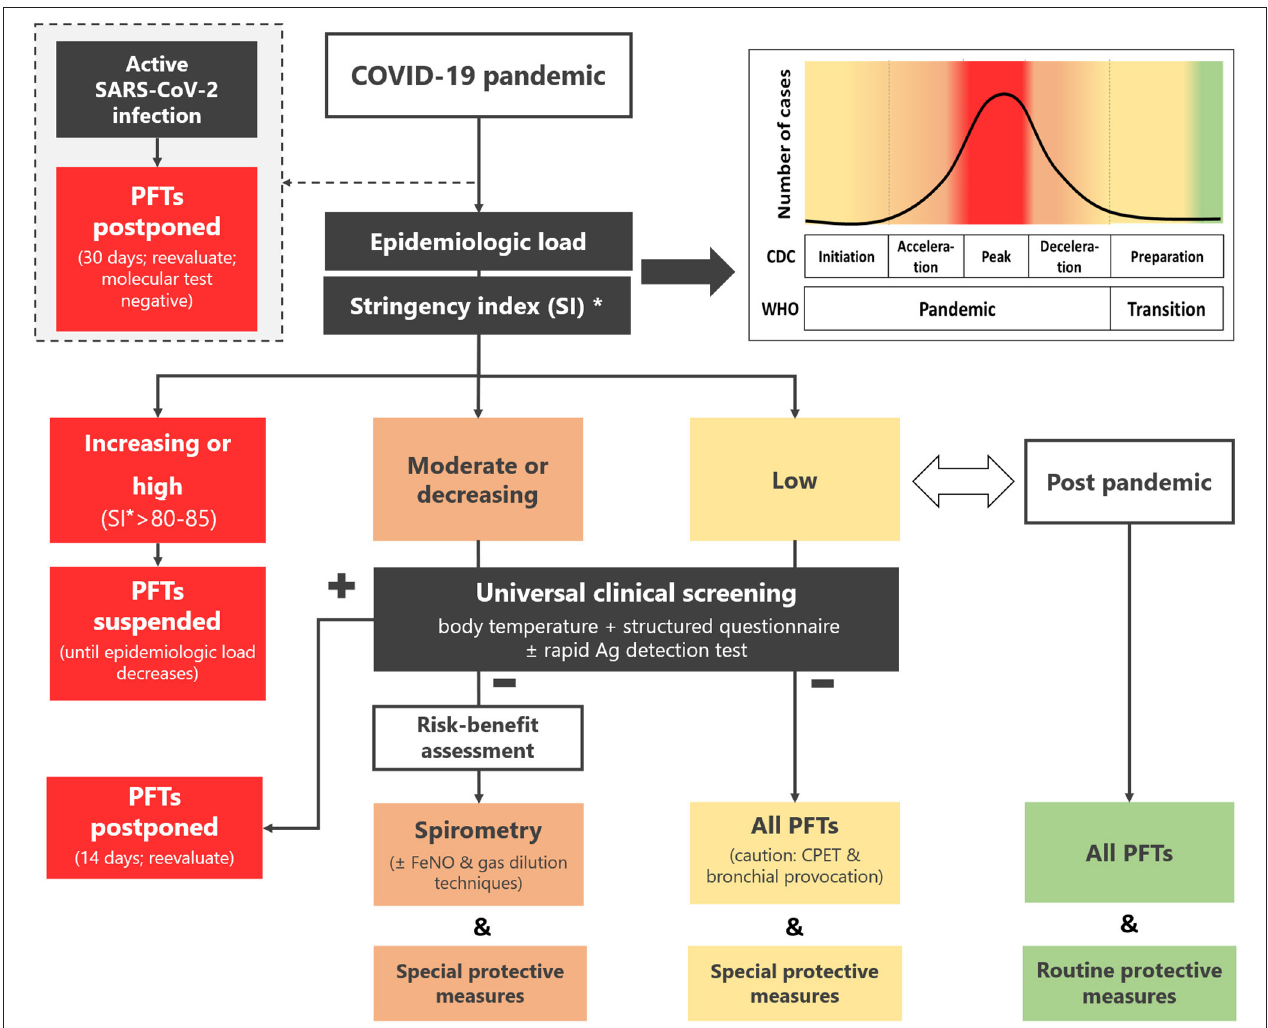
FIGURE 1 | Recommendation of the Hellenic Pediatric Respiratory Society regarding pulmonary function testing in children and adolescents during the COVID-19 pandemic and beyond. *Available online at: https://ourworldindata.org/covid-government-stringency-index#containment-and-health-index. PFTs, pulmonary function tests; CDC, Centers for Disease Control and Prevention; WHO, World Health Organization; FeNO, fraction of expired NO; CPET, cardiopulmonary exercise testing; SI, stringency